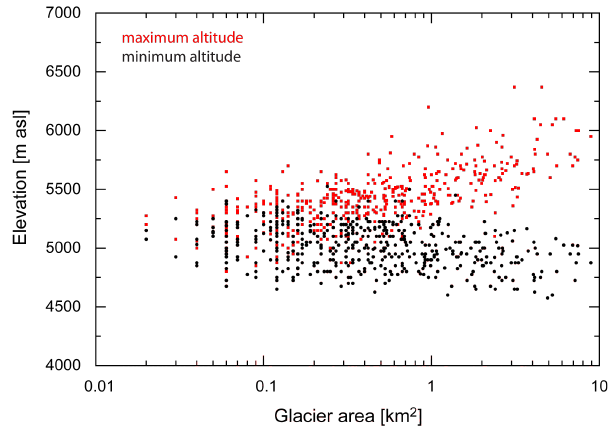
Fig. 2. Maximum and minimum altitude related to the glacier area Figure 2: Maximum and minimum altitude related to the glacier area for all glaciers in the CV 2 for all glaciers in the CV in 1962 (based on the Peruvian glacier in 1962 (based on the peruvian glacier inventory). 3